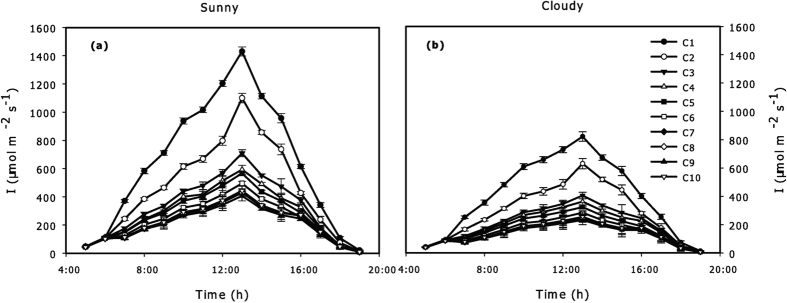
Diurnal changes in the incident photosynthetic photon flux density (I) in ten observed areas during sunny (a) and cloudy (b) conditions in summer. Different symbols are used to indicate different areas: ● = C1, ○ = C2, ▼ = C3, △ = C4, ■ = C5, □ = C6, ♦ = C7, ⋄ = C8, ▲ = C9, ▽ = C10. All values are means ± SE; n = 120.